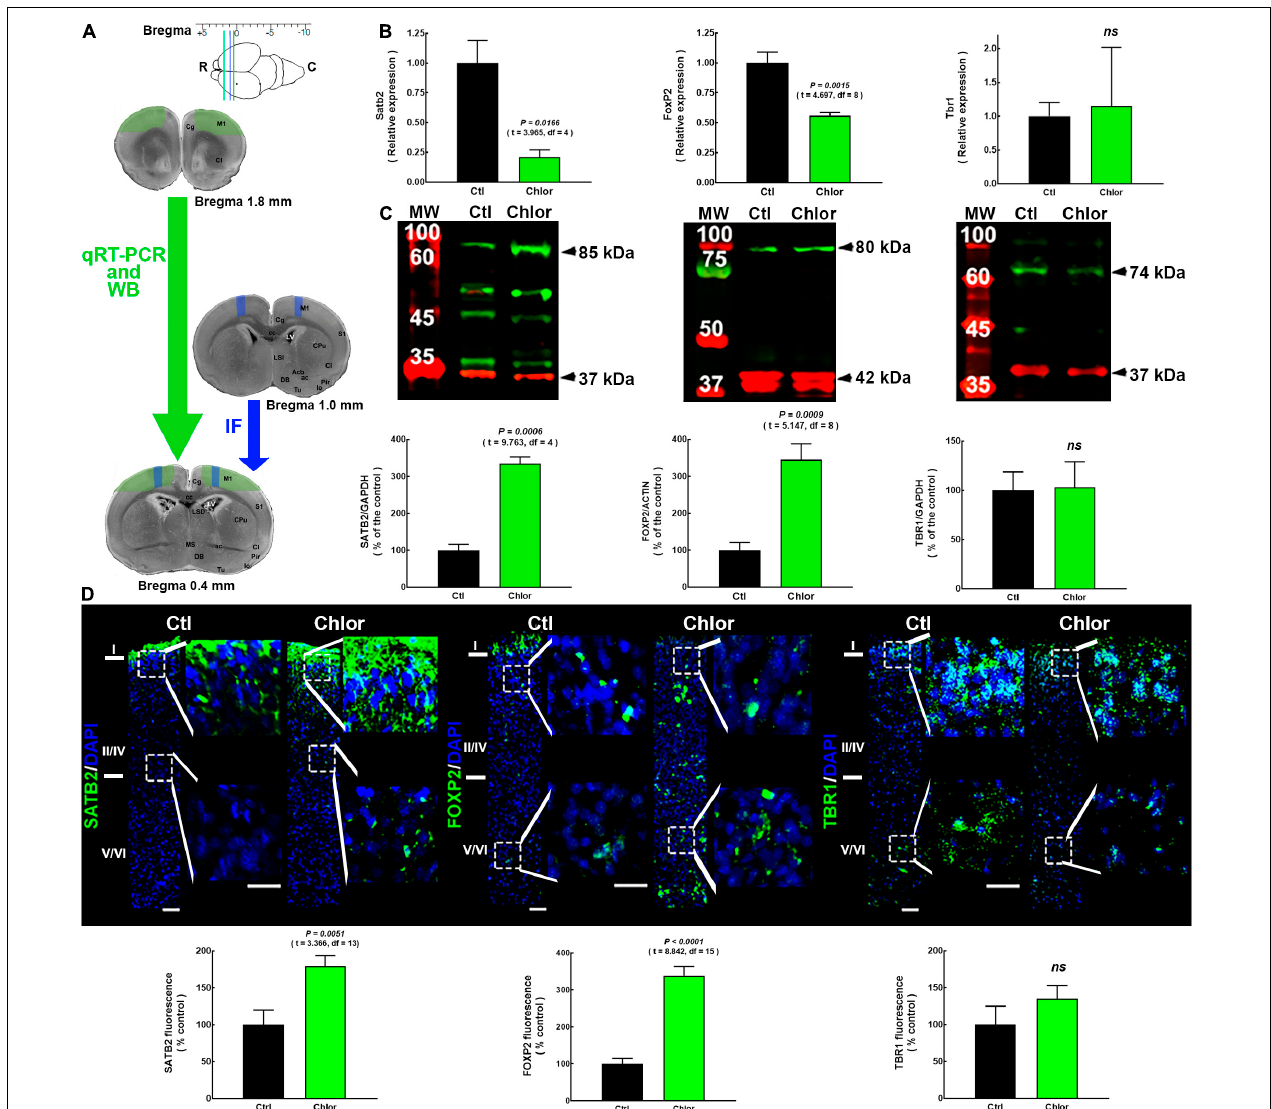
FIGURE 1 | SATB2, FOXP2, and TBR1 expression and distribution in the primary motor cortex of neonates from control and chlorpheniramine-treated dams. (A) Upper, image indicating the bregma levels used for qRT-PCR and Western blot (green lines), and immunofluorescence analysis (space between the blue and the caudal green lines). Lower, representative images of coronal brain slices indicate the zones dissected for qRT-PCR by (green area; 1.8–0.4 mm from bregma, as indicated by the green arrow). The blue area indicates the zone where micrographs were taken of slices (1.0–0.4 mm from bregma, blue arrow). R, rostral; C, caudal; IF Immunofluorescence. Modified from Khazipov et al. (2015). (B) qRT-PCR analysis of Satb2, FoxP2, and Tbr1. Values were normalized to the relative expression of control animals using the 2 − (cid:49)(cid:49) CT method and are means ± SEM (n = 3-5; P0). (C) Upper, representative Western blots for SATB2 (green, 85 kDa), FOXP2 (green, 80 kDa), TBR1 (green, 74 kDa), and the internal controls GAPDH (red, 37 kDa) or α -actin (red, 42 kDa). Bands on the left lanes are molecular weight ladders (MW). Lower, quantitative fluorometric analysis for SATB2, FOXP2, and TBR1. Values are expressed as percentage of the fluorescence ratio of control values and are means ± SEM ( n = 3–5; P0). (D) Upper, representative M1 reconstructions from five micrographs (10 × ) of SATB2, FOXP2 and TBR1 (green) immunodetection and DAPI-stained nuclei (blue), at postnatal day zero (P0) from Control (Ctl) and Chlorpheniramine (Chlor) groups ( n = 3–6; P0). Zoom images (400%) of the dotted white squares of the superficial and deep neocortex are shown on the right of each representative image. Scale bars correspond to 50 and 25 µ m for 10 × and zoom, respectively. Lower, quantitative analysis of the immunofluorescence of SATB2, FOXP2, and TBR1. Values are expressed as percentage of the fluorescence of controls and are means ± SEM ( n = 3–6; P0). The statistical analyses in (A–C) were performed with unpaired Student’s t -test. ns, non-significant